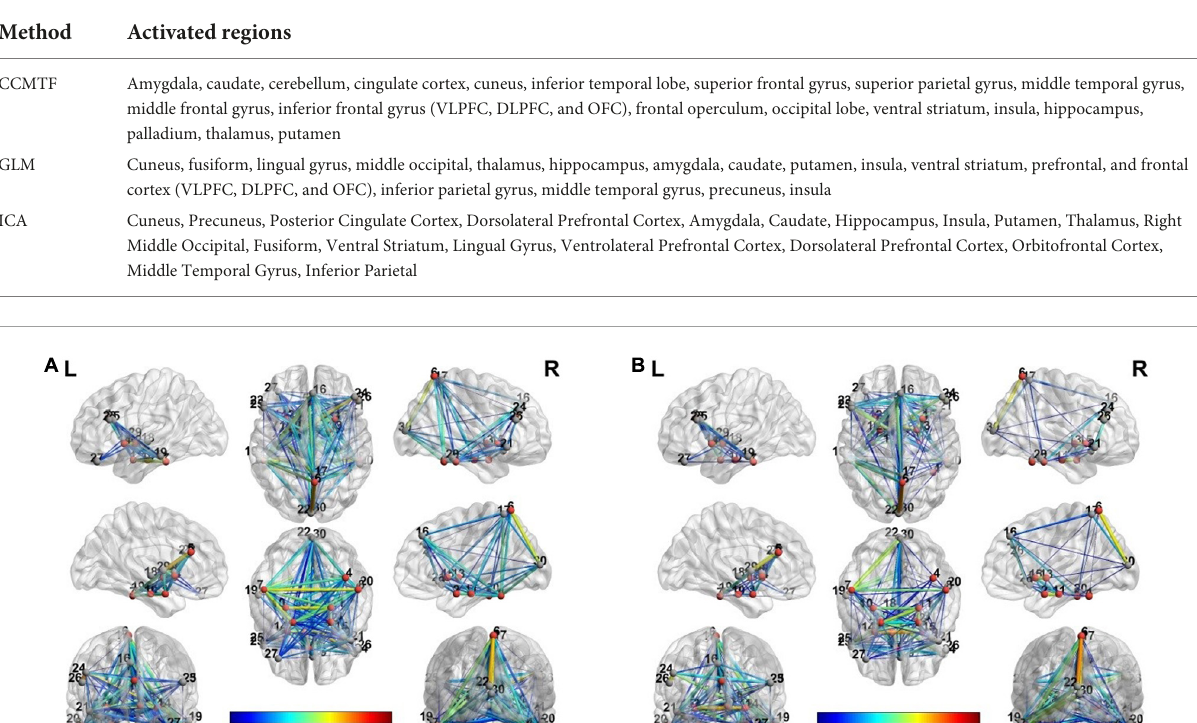
the upregulation state but not in the view state were statistically compared with those in the real group and then corrected for multiple comparisons using FDR at the level of 0.05 to extract the significant links as a result of neurofeedback. These links are reported in Table 2